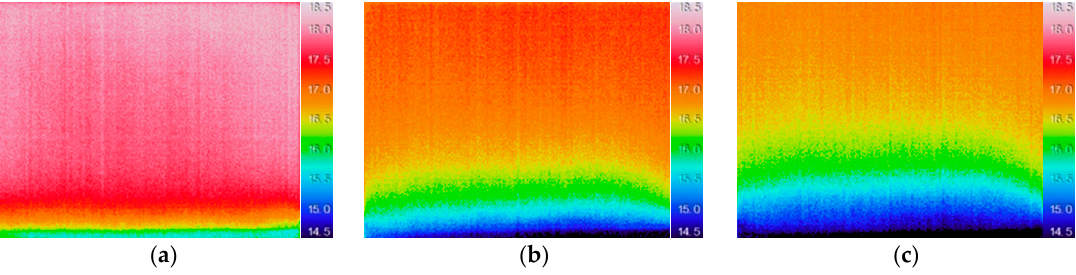
Figure 2. Thermal images of the entire specimen: ( a ) t = 0 h (immediately after the beginning of humidification); ( b ) t = 4 h; ( c ) t = 24 h.